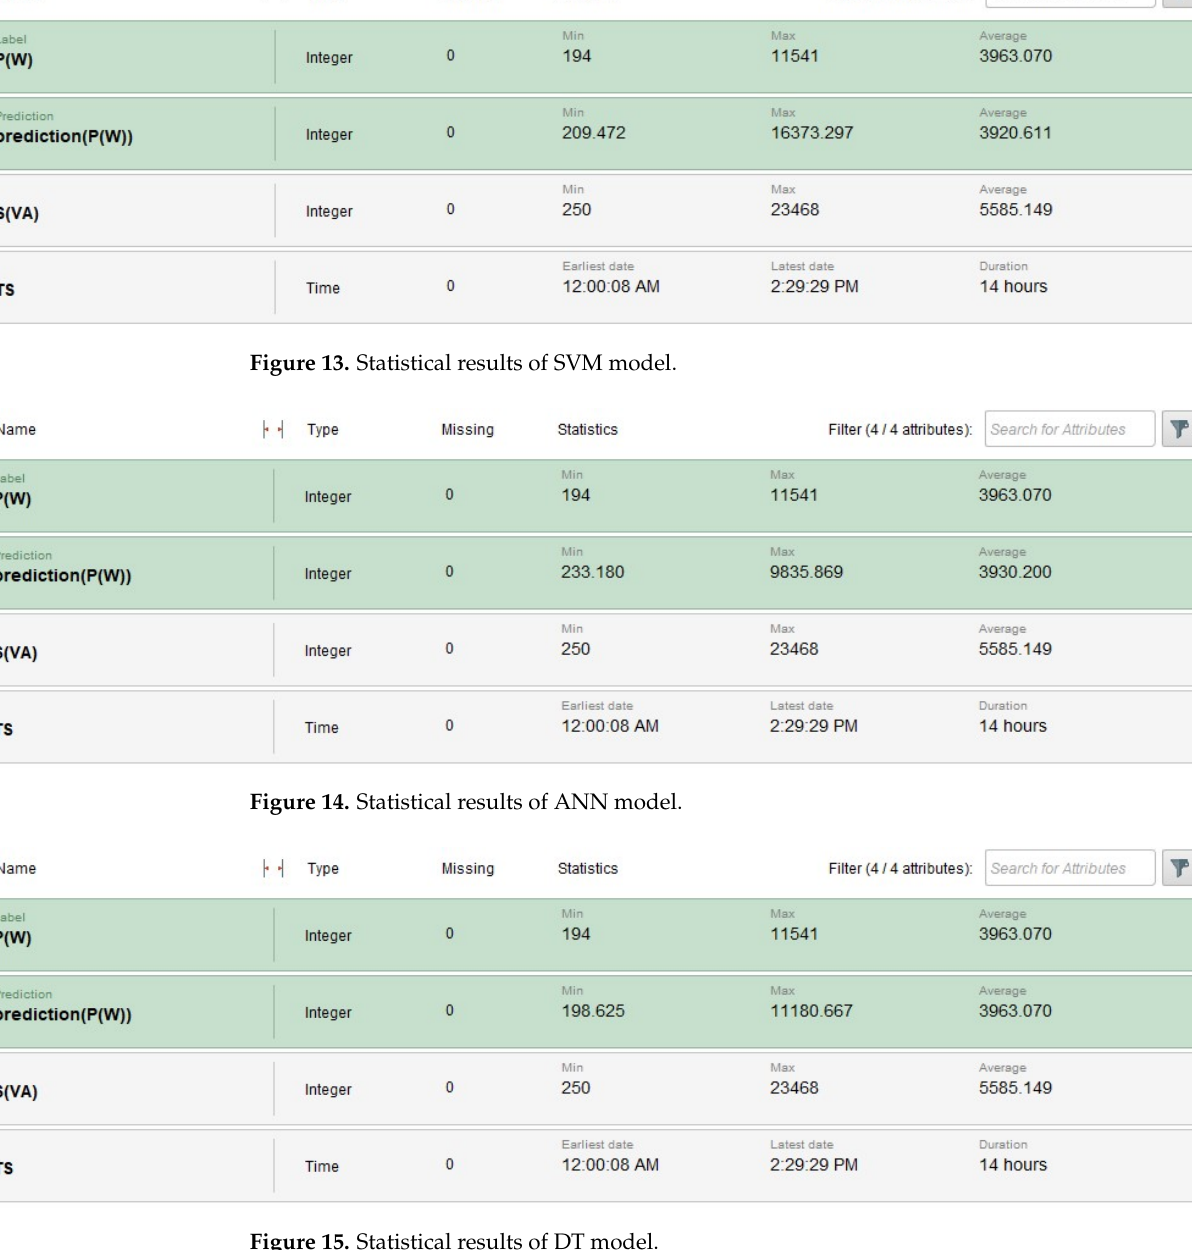
Figure 15. Statistical results of DT model.